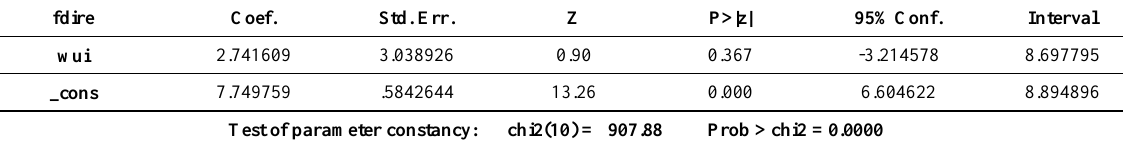
Table 2. Swamy S Homogeneity Test Results.